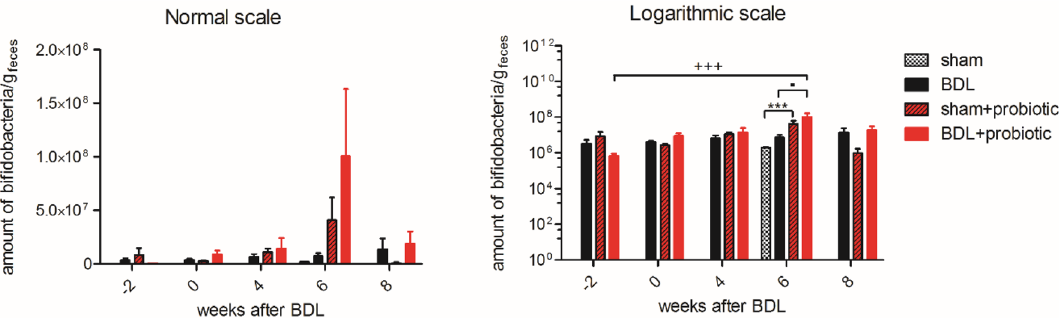
Figure 1. Amount of Bifidobacteria /g of faeces expressed in normal and logarithmic scale. One-way ANOVA was used for statistical analysis, shown on the logarithmic scale graph: *between sham and sham + probiotics at week 6, ▪ between BDL and BDL + probiotic at week 6, + between BDL + probiotic between week − 2 and week 6.